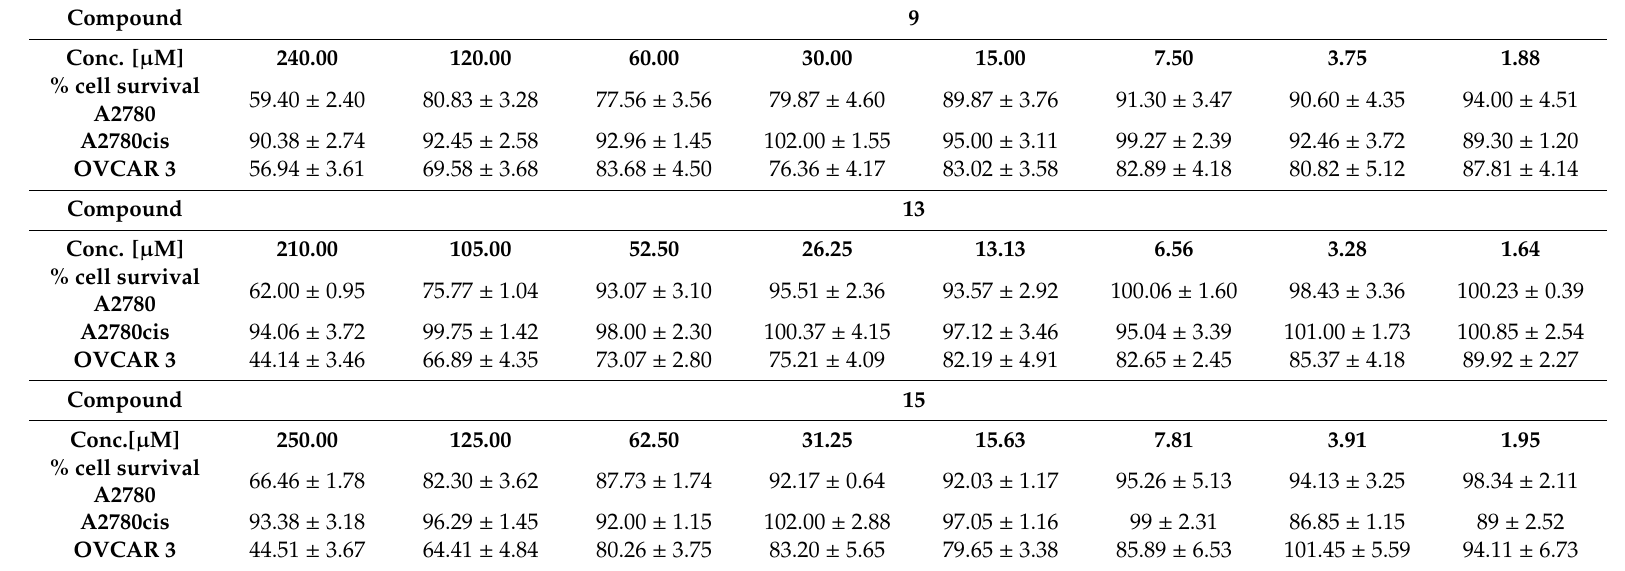
Table 4. Survival rate of ovarian adenocarcinoma cells treated with serial concentrations of 9 , 13 and 15 respectively, versus the untreated reference cell population expressed as median values ± standard errors of means